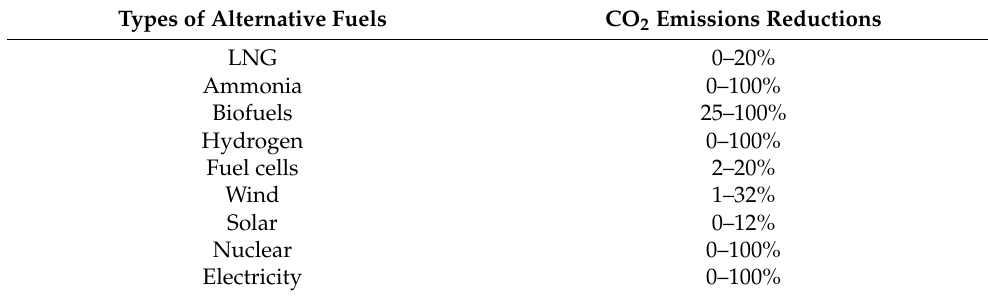
Table 2. Eventual CO 2 emission reductions by using alternative fuels according to